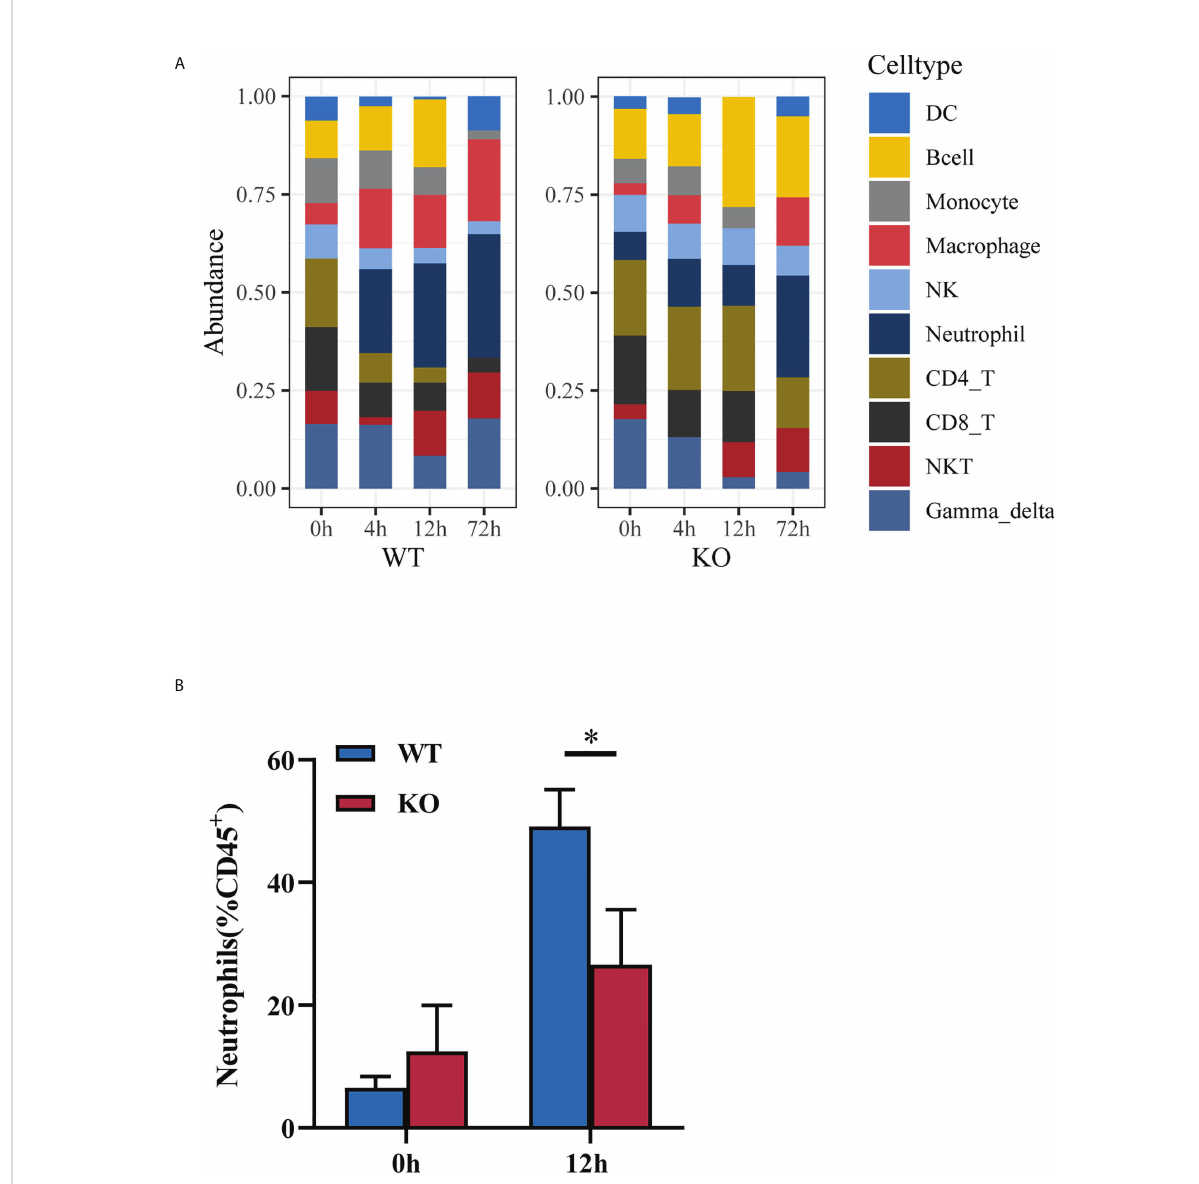
FIGURE 6 The degree of neutrophil chemotaxis and recruitment in Csf2ra -/- mice was decreased relative to WT mice. (A) Immune cell abundance analyzed by ImmuCellAI at different timepoints for Csf2ra KO mice and WT mice. (B) Bar graph showing the percentage of neutrophils measured by fl ow cytometry. Two-way ANOVAs followed by Sidak ’ s multiple comparison tests; *P